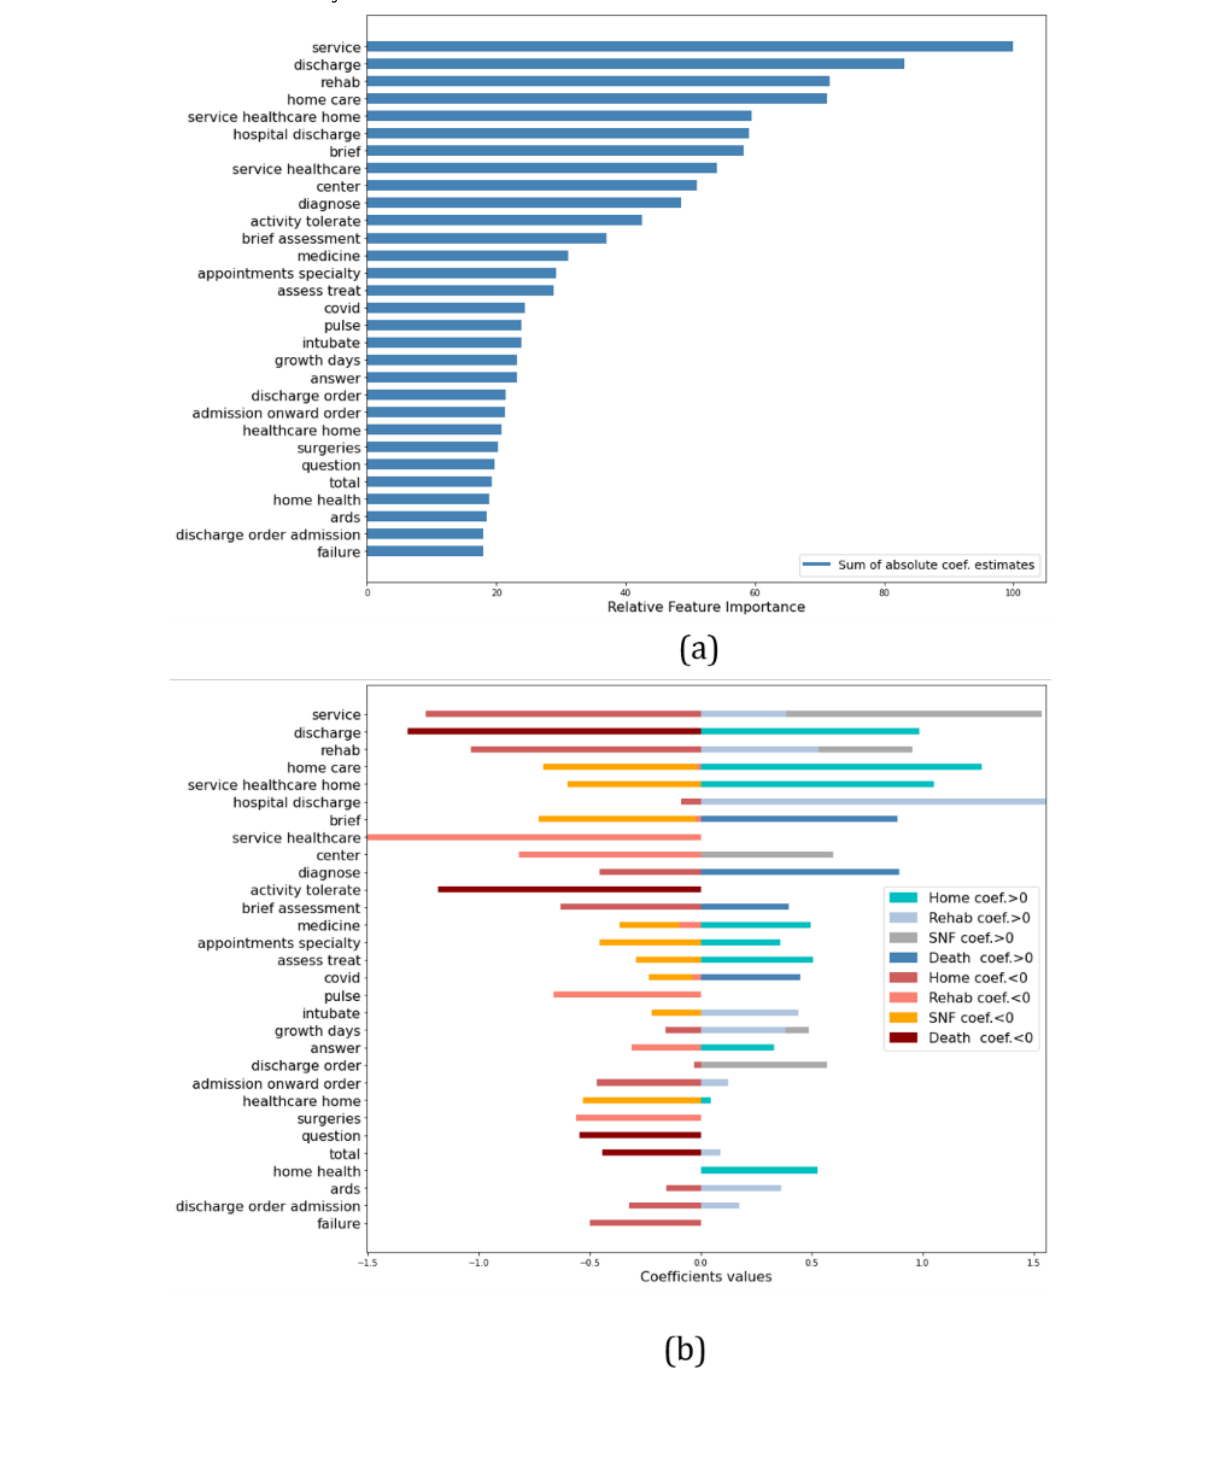
Figure 3. Relative importance of top 30 features obtained with the model coefficients estimates for (A) the sum of the absolute coefficients values and (B) the coefficients values discriminated by outcome. Coef: